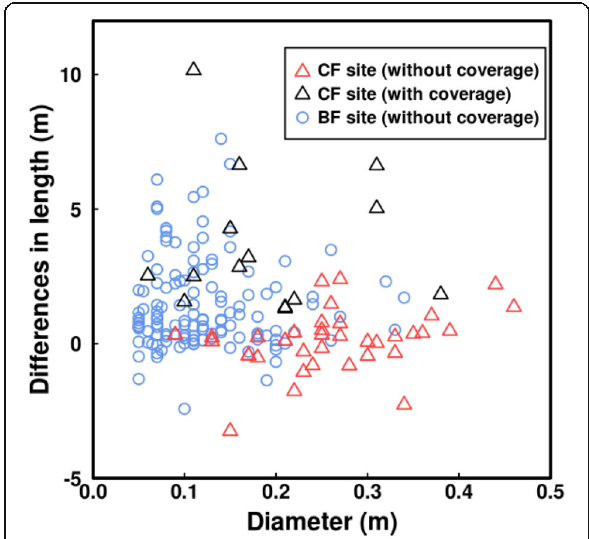
Fig. 7 The differences between the extracted and measured lengths of the wood pieces at both broadleaf forest (BF) and coniferous forest (CF) sites as functions of the measured diameter. Differences in length were calculated by subtracting the extracted length from the measured length, similar to Fig.